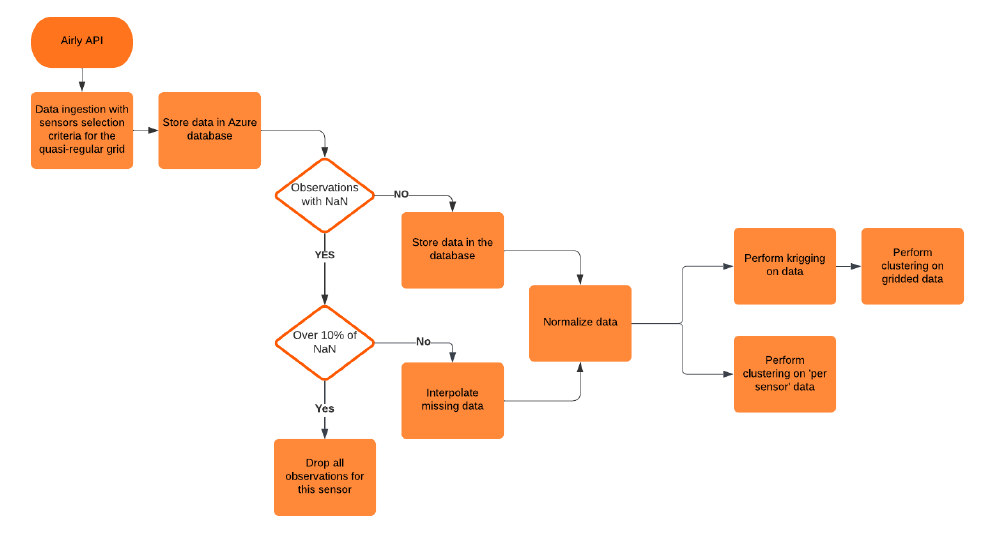
Figure 2. Data preparation